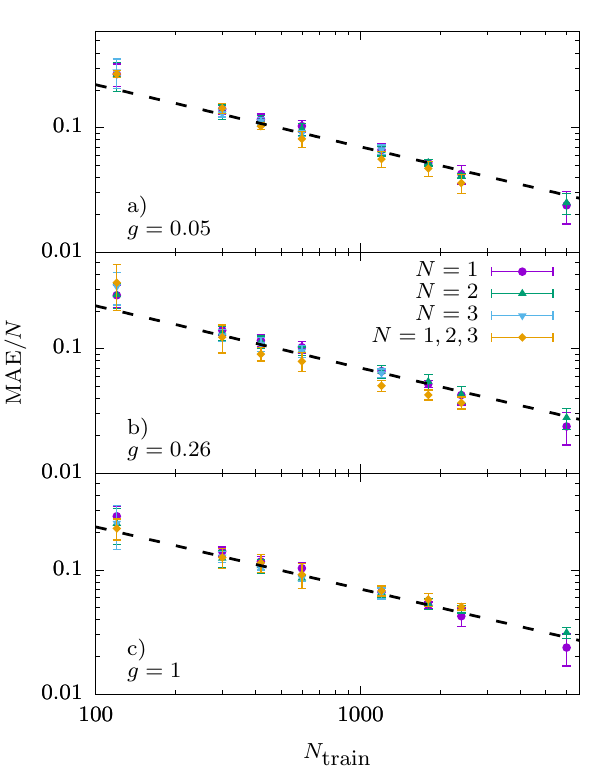
Figure 2: Mean absolute error per particle MAE / N , computed on the test ground- state energies, as a function of the number of instances in the training set N The different symbols correspond to training on homogeneous datasets including a unique particle number (either N = 1, N = 2, or N = 3) and to combined training and testing on heterogeneous datasets including all three particle numbers ( N = 1,2,3). The three panels correspond to different interaction strengths g . The errorbar is the estimated standard deviation of the mean obtained with up to eight independent models trained with different pseudo-random numbers. The dashed line corresponds to a power-law scaling with b = 0.5, see text for